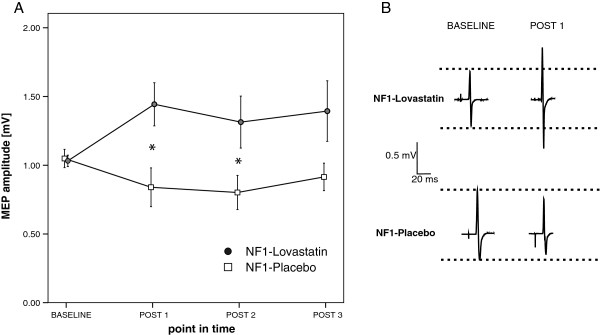
Time course of MEP amplitudes of patients with NF1 after PAS with and without lovastatin. A) Shown are data from the NF1 patients (n = 11). Abscissa depicts point in time and ordinate mean MEP amplitude. Administration of lovastatin 4 days before PAS led to a rescue of motor cortex plasticity in patients. Asterisks indicate significant differences between the two drug conditions (p < 0.05, paired t test) and error bars represent ± standard error of the mean. B) MEP amplitudes from one representative subject for placebo and lovastatin condition before and at POST 1 after PAS. Shown are averages of 20 MEP trials in each case.